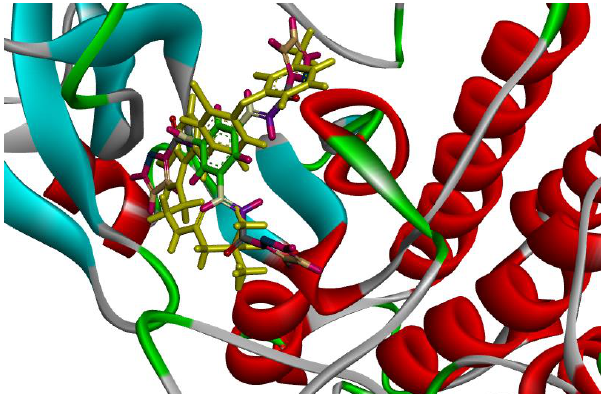
Figure 3. Solid ribbon representation of 3POZ docked with crystal structure of TAK-285 (yellow color) and inhibitor 1a (colored) in the active site.